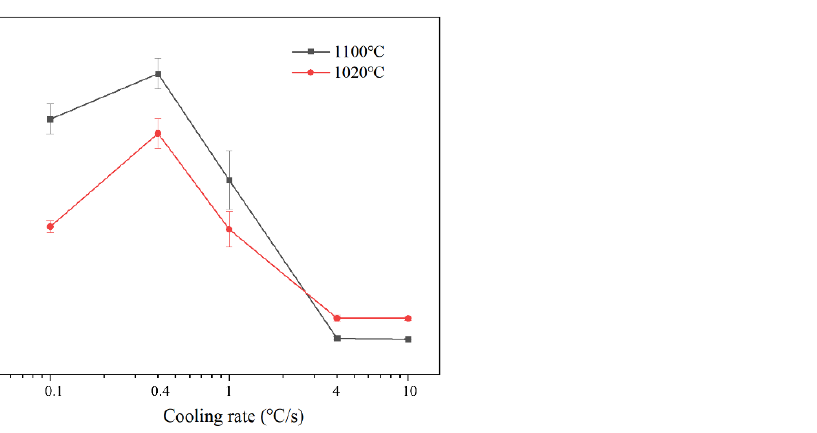
Figure 12. The schematic of the formation process of precipitated O phase with cooling from ( a ) B2 region, ( b ) B2 + α 2 region.